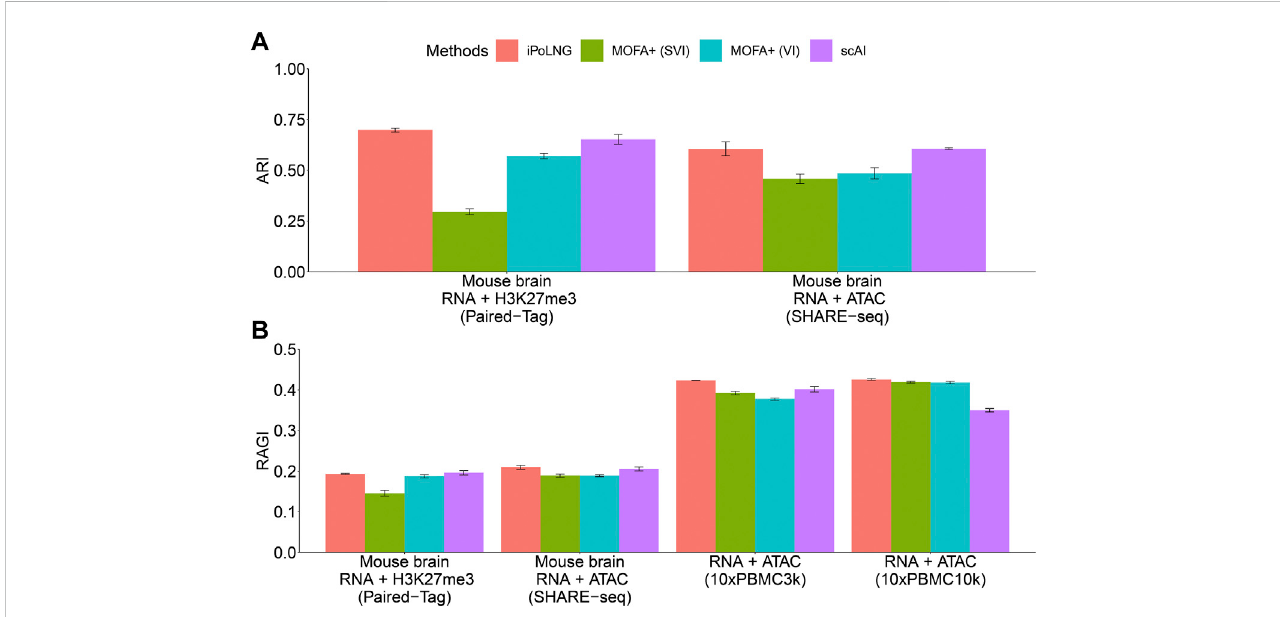
FIGURE 2 Clustering performance of iPoLNG, MOFA+ (SVI), MOFA+ (VI), and scAI on real data. (A) Comparison of ARI scores for Paired-Tag and SHARE-seq with given cell-type labels. (B) Comparison of RAGI scores for Paired-Tag, SHARE-seq, 10xPBMC3k, and 10xPBMC10k. The error bar represents the mean and standard error in 10 runs with different random seeds in the clustering